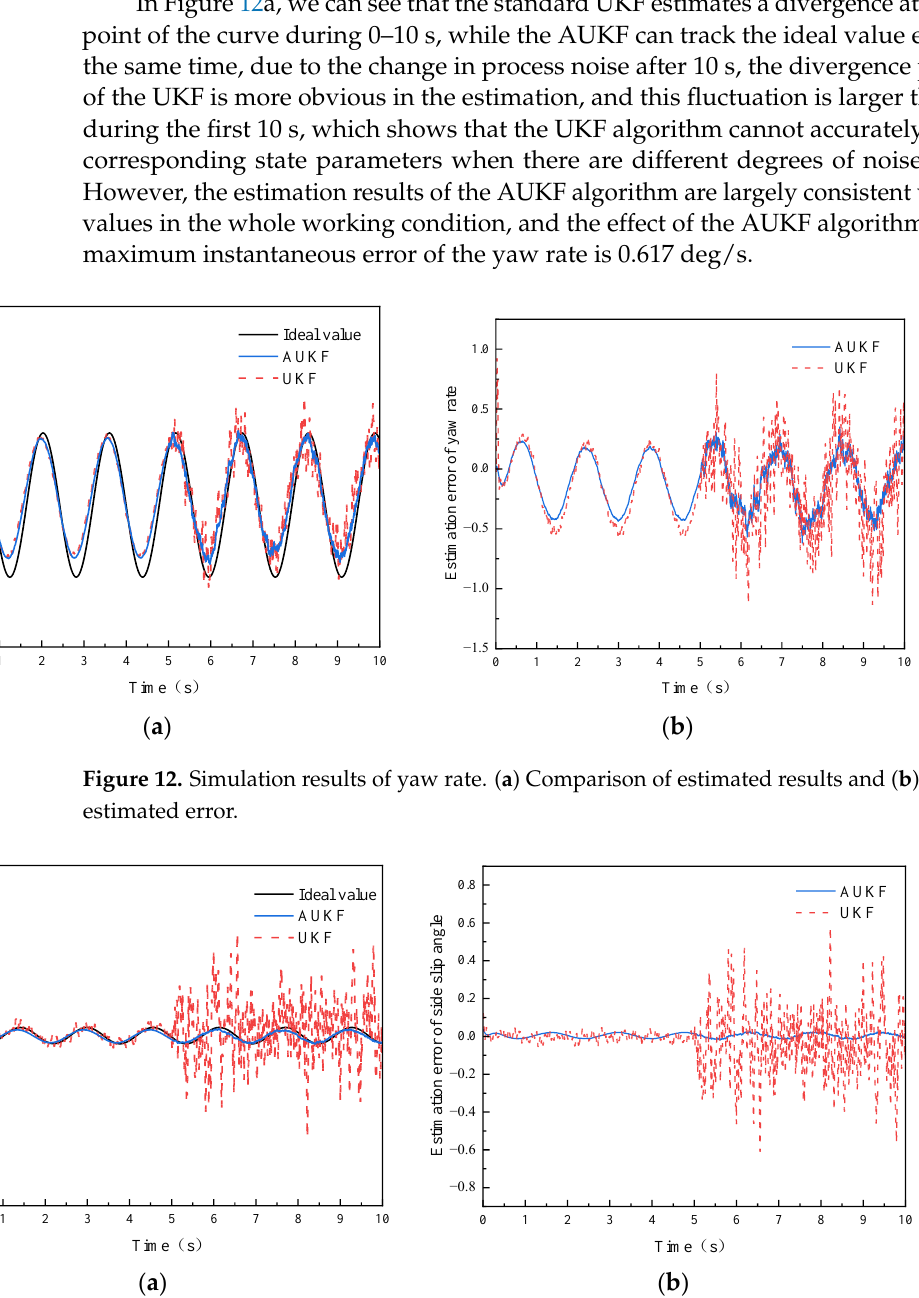
Table 3. RMSE of the two algorithms during the entire duration of the process.